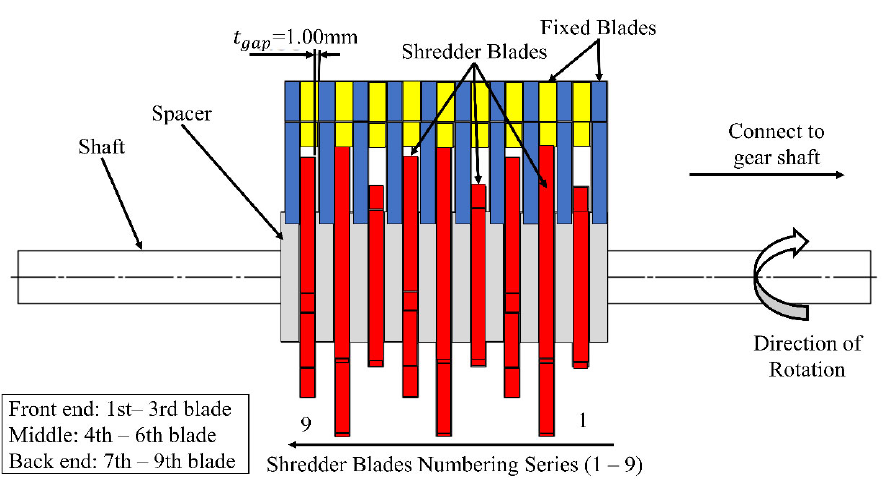
Figure 4. The configuration and numbering of the shredder blades in the shredder machine.